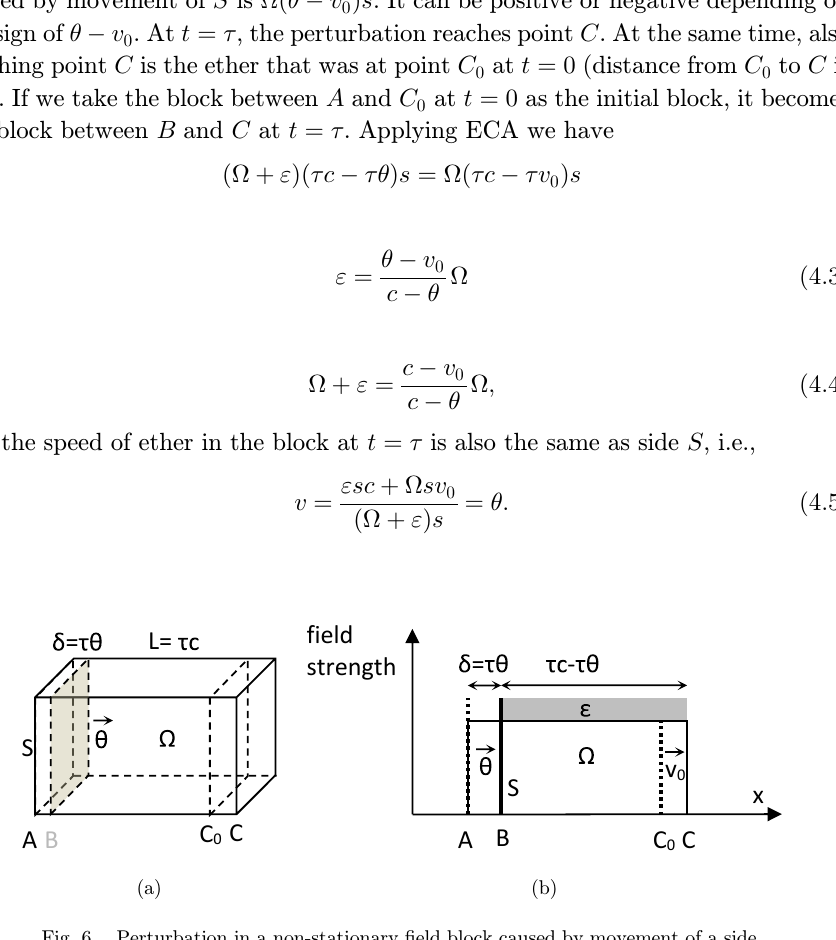
Fig. 6. Perturbation in a non-stationary ¯eld block caused by movement of a